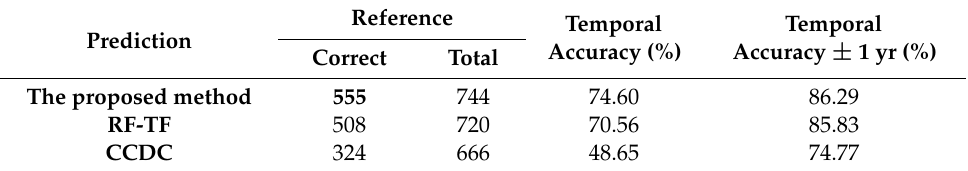
Table 6. The accuracy assessment of change detection in the temporal